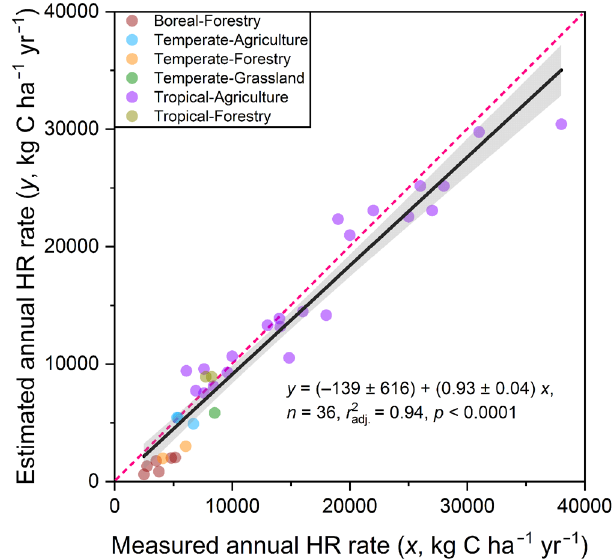
Fig. 7 Linear correlation between the estimated and measured annual soil heterotrophic respiration (HR) rates across climate zones and land uses for drained peatlands. The measured annual HR was synthesized from previous publications. The predicted annual HR was obtained using Eqs. (6 – 13) in the Methods. The climate zone, land use, and drainage duration information were directly extracted from these publications, which simultaneously reported the measured annual HR. For details related to the estimation of annual HR, see Eqs. (6 – 13) in the